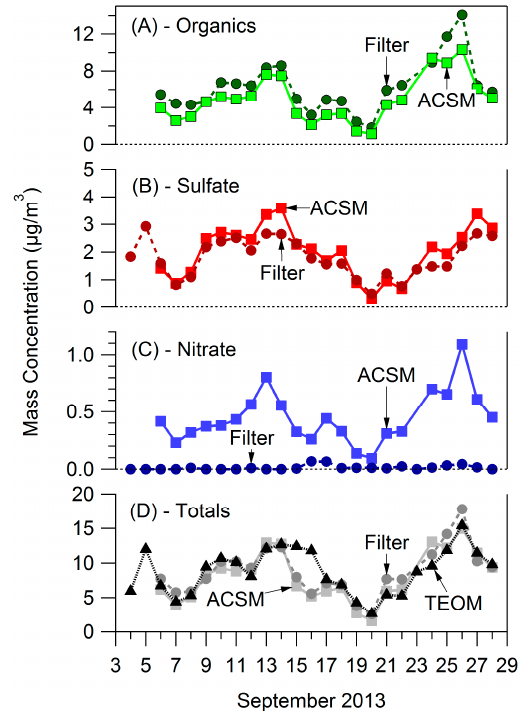
Figure A4. Instrument comparisons between the PM 1 ACSM, PM 2.5 filter, and PM 2.5 TEOM measurements for. ( A ) Organics, ( B ) Sulfate, ( C ) Nitrate, ( D ) Totals.